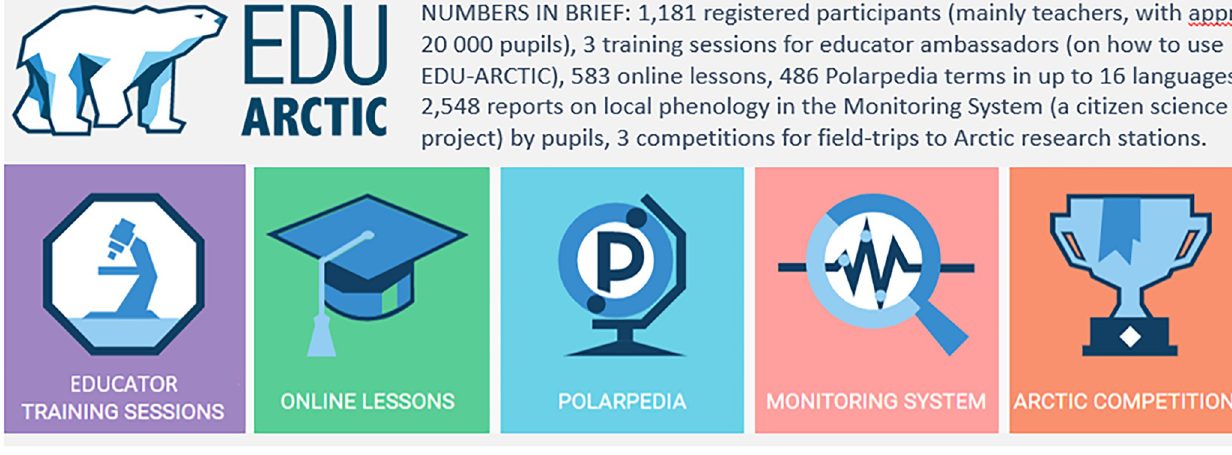
Fig 1. Overview of learning components in the EDU-ARCTIC open schooling course (2016–2019). All learning resources were freely available to anyone registering on the portal, at no cost, but specifically targeted European teachers with their students 13–20 years of age.